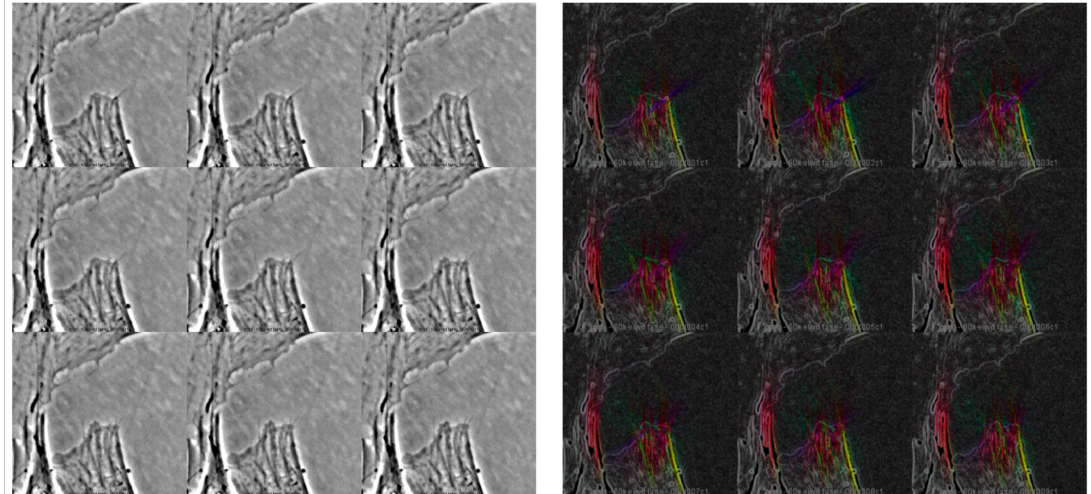
Figure 1. ( Left panel ): time lapse acquisition of cell movement during 3 min. ( Right panel ): di- rectionality map showing vectors, represented as angle and module, of cellular movement of the same frames. The intensity of the movement and the distance covered during a 0.05-Hz acquisition together imply an actin and tubulin turnover rate with higher orders of magnitude of frequencies because of the dimensions of the single monomers that compose the mesh of the cytoskeleton. The microphotographs show a 60 × phase contrast acquisition of dermal fibroblast